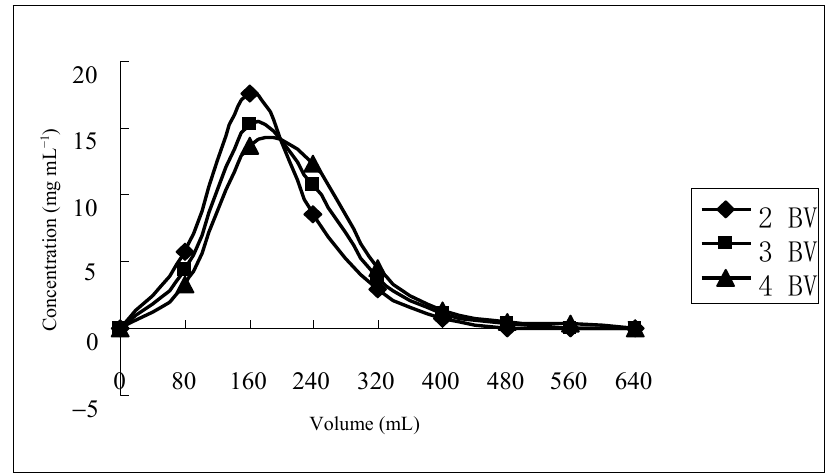
Figure 4. The effects of eluate flow rate on ratio of desorption with the ethanol-water (40%, v / v ) solution in dynamic adsorption.